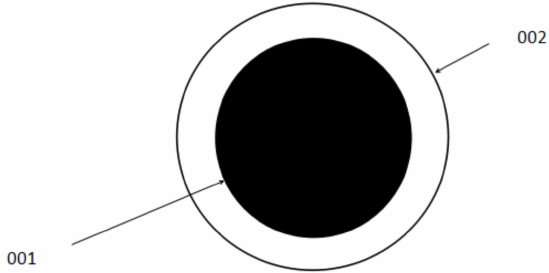
Figure 6. Schematic diagram of a thin film of Ti 3 C 2 or Ti 3 C 2 :Fe 3+ /Co 2+ /Ni 2+ powders obtained